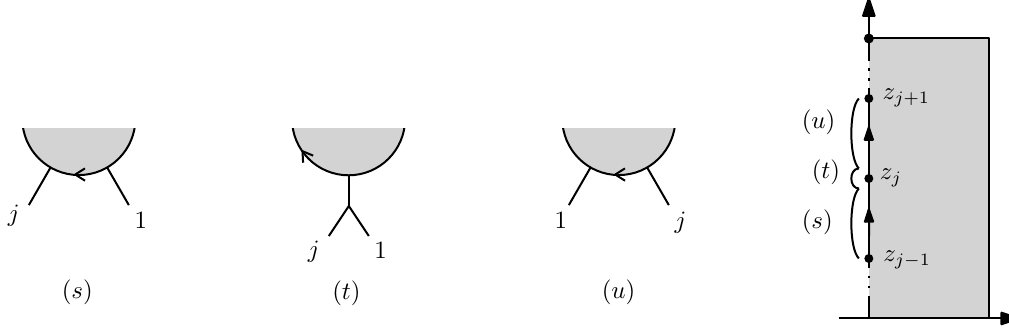
Figure 9 . Illustration where the s -, t -, u -channel graphs come from on the